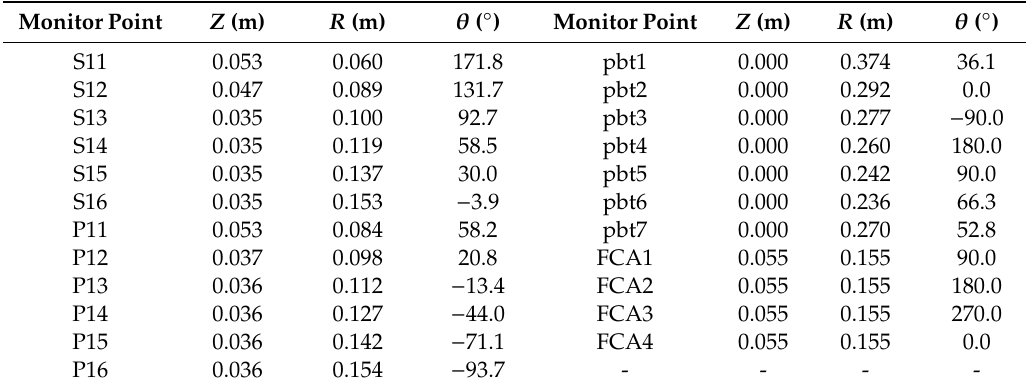
Figure 3. Monitor point arrangements in the numerical simulations. ( a ) Impeller; ( b ) volute; and ( c ) front chamber. Table 2. Cylindrical coordinates of the monitor points.